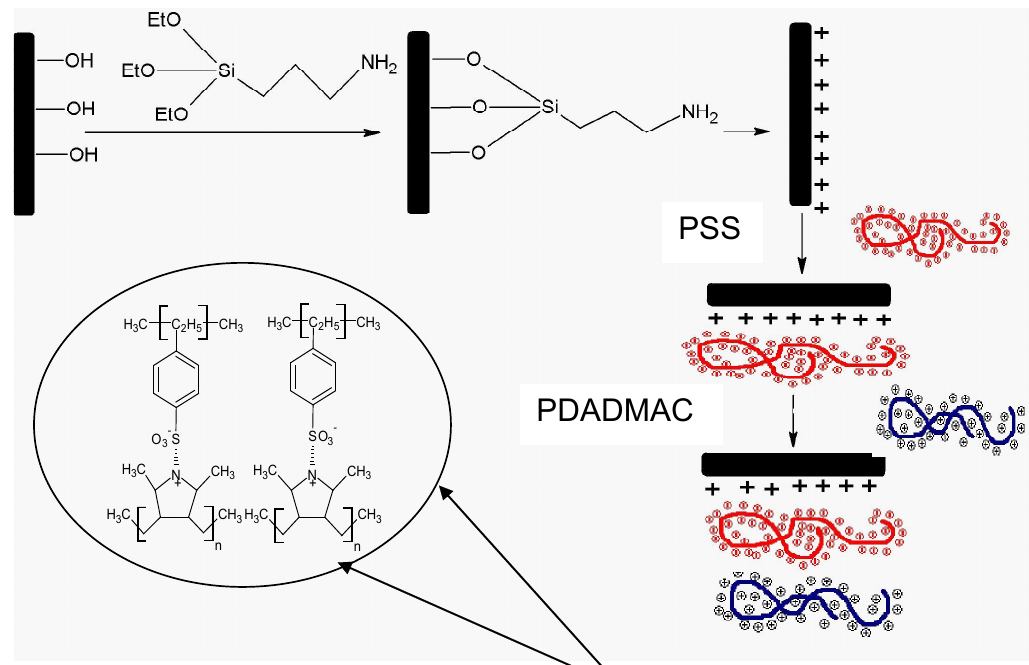
Figure 1. Schematic representation of the LbL assembly on silicon.